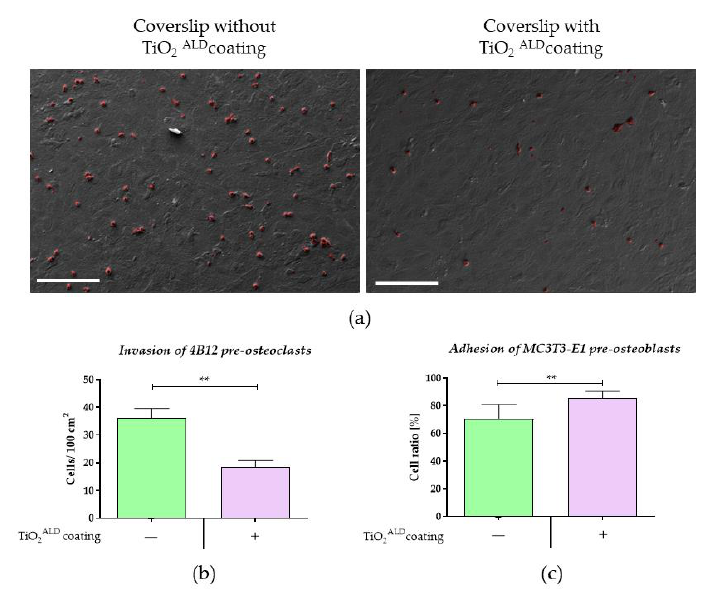
Figure 9. The invasion of preosteoclasts in the control co-culture (TiO 2 -) and the culture propagated on TiO 2 coatings obtained by ALD (TiO 2ALD coatings + ; experimental co-culture): ( a ) the representative pictures of MC3T3-E1 co-cultured with pre-osteoclasts. 4B12 cells were visualised and coloured red (GNU Image Manipulation Program 2.10.18). The pictures were captured using SEM under 500× magnification (scale bar = 20 µm); ( b ) the results of statistical analysis showing the number of preosteoclasts. (significant differences are marked with asterisks (** p < 0.01)).